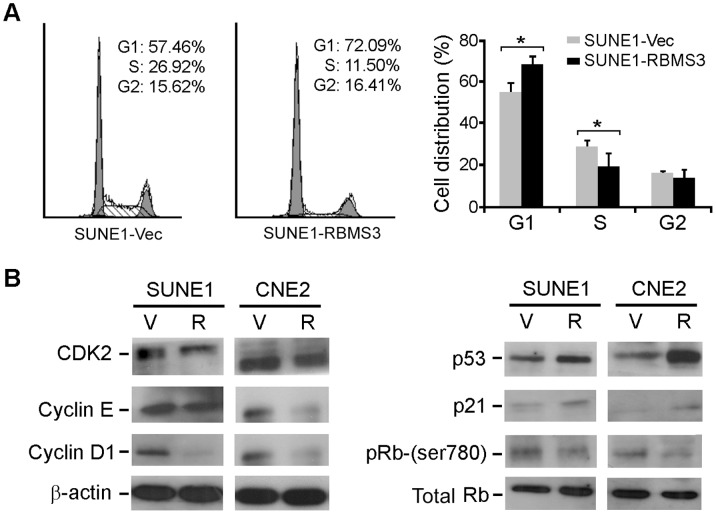

RBMS3 arrests cell cycle at the G1/S checkpoint.(A) Representative and summary of DNA content detected by flow cytometry showed that the percentage of cells in the S phase was lower while the percentage of cells in the G1 phase was higher in SUNE1-RBMS3 cells than that in SUNE1-V1 cells. (* p<0.05, Student’s t-test). Values were expressed as mean ± SD of three independent experiments. (B) Protein expressions of cyclin D1, cyclin E, CDK2, p53, p21, Rb and Rb (Ser780) were compared between RBMS3- and empty vector-transfected NPC cells. β-actin was used as a loading control.